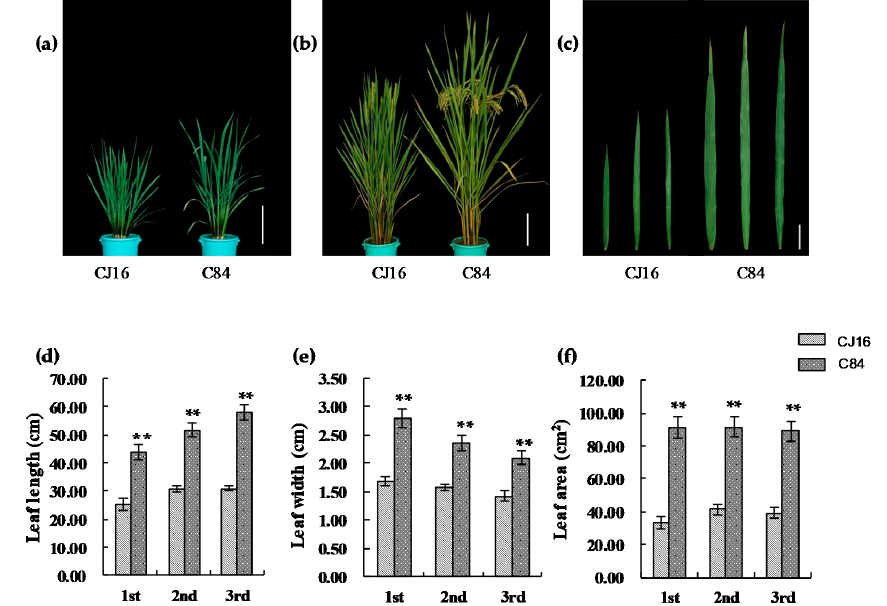
Figure 1. The leaf shape of parents of recombinant inbred lines (RILs). ( a ) Plant morphology at tillering stage; bar = 18 cm. ( b ) Plant morphology at heading stage; bar = 18 cm. ( c ) The top three leaves’ shape of CJ16 and C84. From left to right are the first leaf, the second leaf, and the third leaf, respectively; bar = 5 cm. ( d ) Comparison of the top three leaves’ length between CJ16 and C84. ( e ) Comparison of the top three leaves’ width between CJ16 and C84. ( f ) Comparison of the top three leaves’ area between CJ16 and C84. Data are represented as mean ± SD ( n = 11). Asterisks represent significant difference determined by Student’s t -test at p -value <0.01 (**), p -value <0.05 (*).